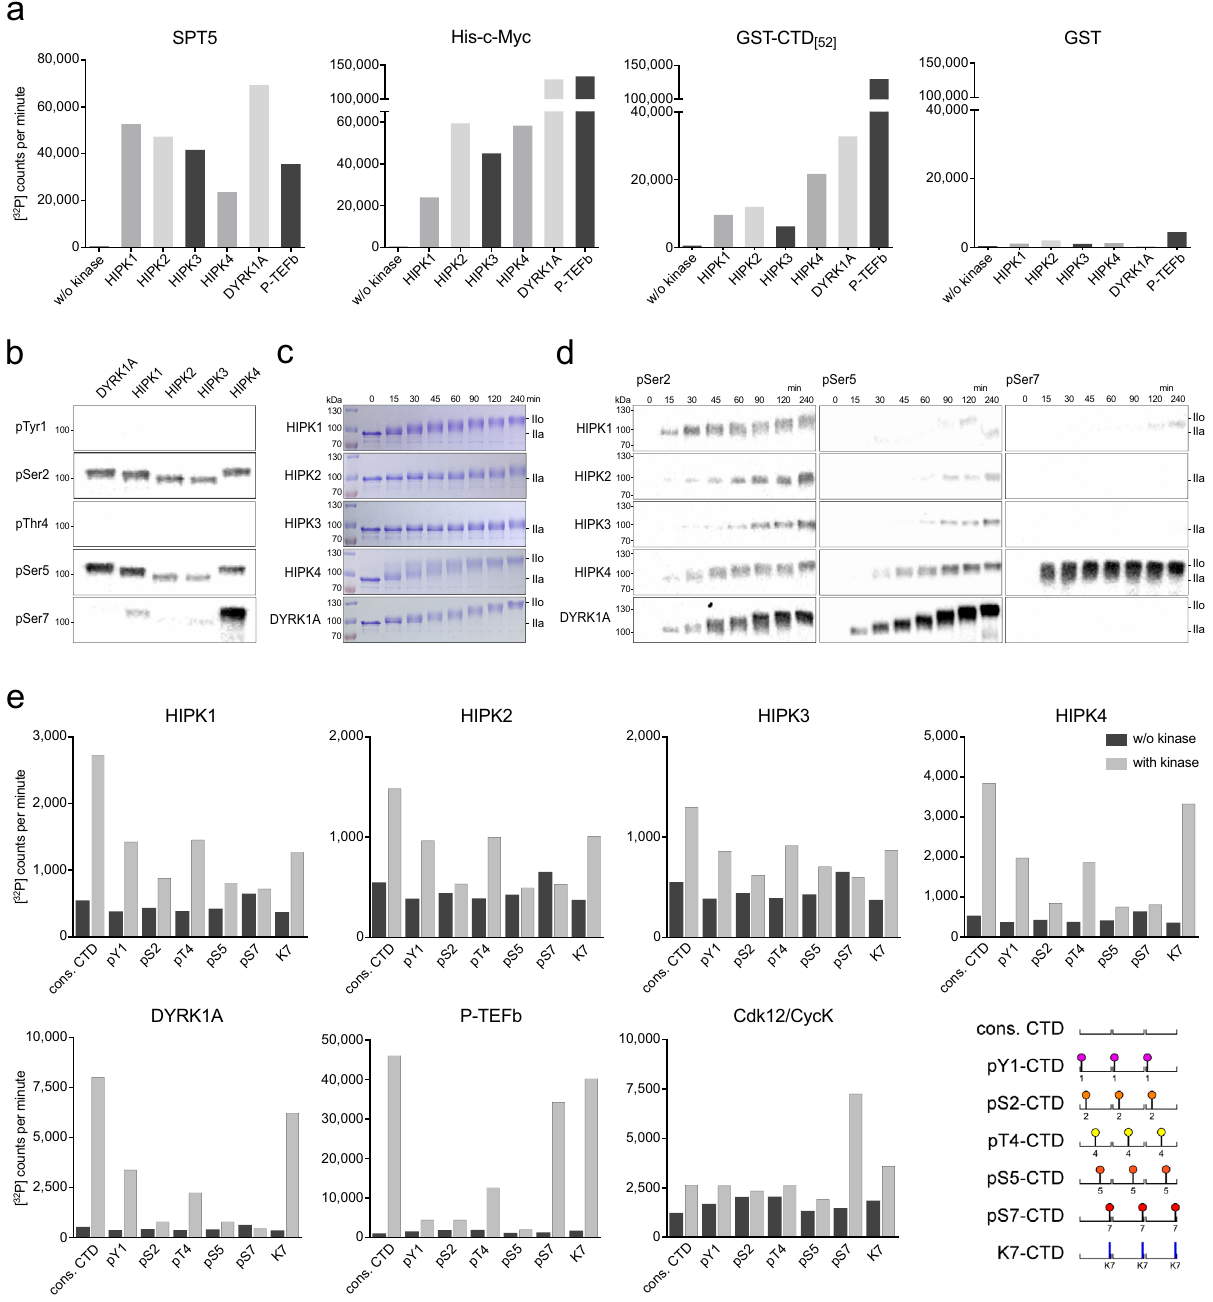
Fig. 5 HIPKs phosphorylate general transcription factors and RNA pol II CTD. a For radioactive kinase activity assays 10 μ M human SPT5, His-c-Myc, GST-CTD [52] , and GST as a control were incubated with 0.2 mM [ 32 P]- γ -ATP either with or without 0.2 μ M kinase for 30 min. b For in vitro kinase assays 10 μ M GST-CTD [52] , 0.2 mM ATP, and 0.2 μ M kinase were incubated for 120 min, and visualized by immunoblotting using RNA pol II CTD speci fi c phosphoantibodies pTyr1 (3D12), pSer2 (3E10), pThr4 (6D7), pSer5 (3E8), and pSer7 (4E12). c Gel shift assays were performed as in ( b ) but in time- course series and visualized by Coomassie staining in SDS gels. Upon phosphorylation the GST-CTD [52] band shifts from the IIa to the IIo form. d In vitro kinase assays were performed as in ( b ) but as time-course series, visualized by immunoblotting. e Radioactive kinase assays were performed as in ( a ) using 150 μ M pre-phosphorylated CTD Peptides as a substrate. Each CTD peptide contained three consensus hepta-repeats with either no modi fi cation (cons. CTD) or with phosphorylation marks continuously set at one residue of the heptad sequence as depicted in the cartoon. The principle was used for Tyr1, Ser2, Thr4, Ser5, Ser7 or a peptide that contained a lysine at position 7. Measurements were performed as duplicates ( n = 2 biologically independent samples) and are depicted as mean. Source data are provided as a Source Data fi